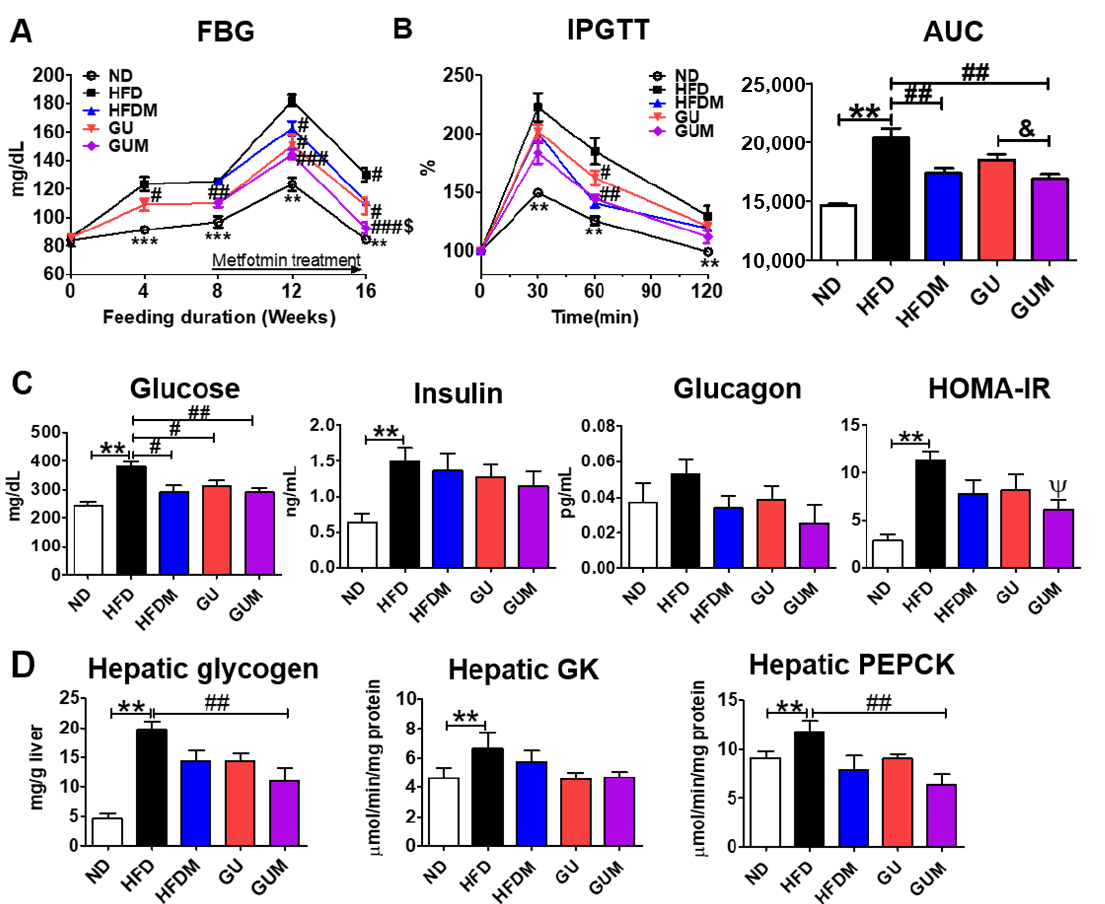
Figure 5. Effect of metformin, G. uralensis Fischer, and their combination after 16 weeks on fasting blood glucose ( A ); IPGTT and AUC ( B ); plasma glucose, insulin, and glucagon levels and HOMA-IR ( C ); and hepatic glycogen content and glucose-regulating enzyme activities ( D ) in C57BL/6J mice fed a high-fat diet. Data are presented as the mean ± SEM. Significant differences between HFD and ND are indicated: ** p < 0.01, *** p < 0.001. Significant differences among the high-fat diet-fed groups are indicated: # p < 0.05, ## p < 0.01, ### p < 0.001. Significant differences between GUM and GU are indicated: & p < 0.05. ND, normal diet (AIN-93G 16 kcal% fat); HFD, high-fat diet (60 kcal% fat); HFDM, HFD + metformin 50 mg/kg; GU ( G. uralensis Fischer), HFD + GU 0.015%; GUM, HFD + GU 0.015% + metformin 50 mg/kg . HOMA-IR = (fasting glucose (mmol/L) × fasting insulin (µIU/mL))/22.5.